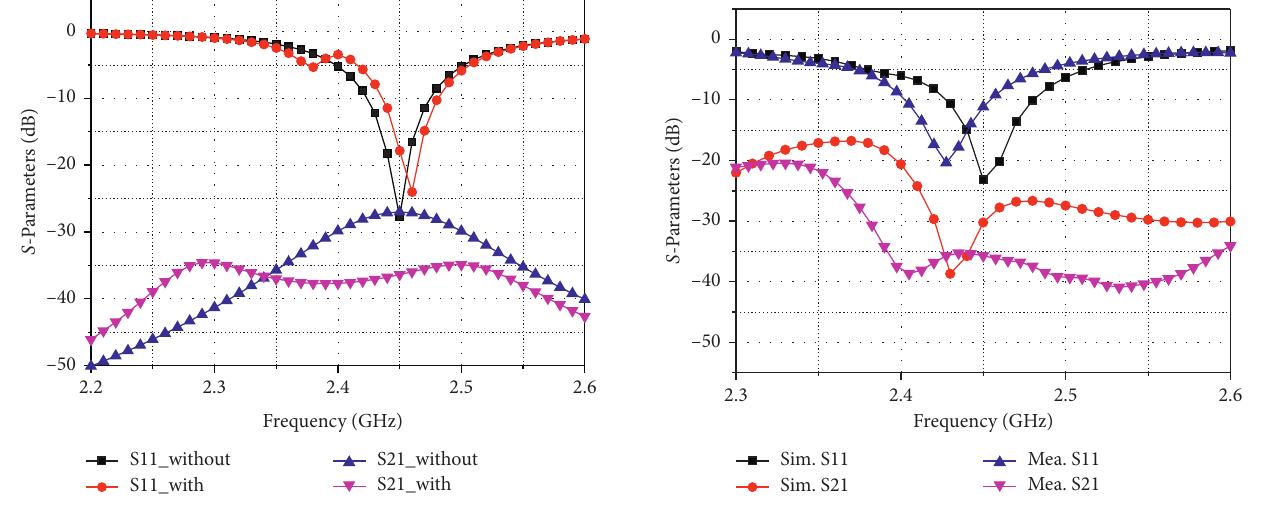
Figure 10: Effect of the decoupling structure on the S -parameters between two PIFA antennas.